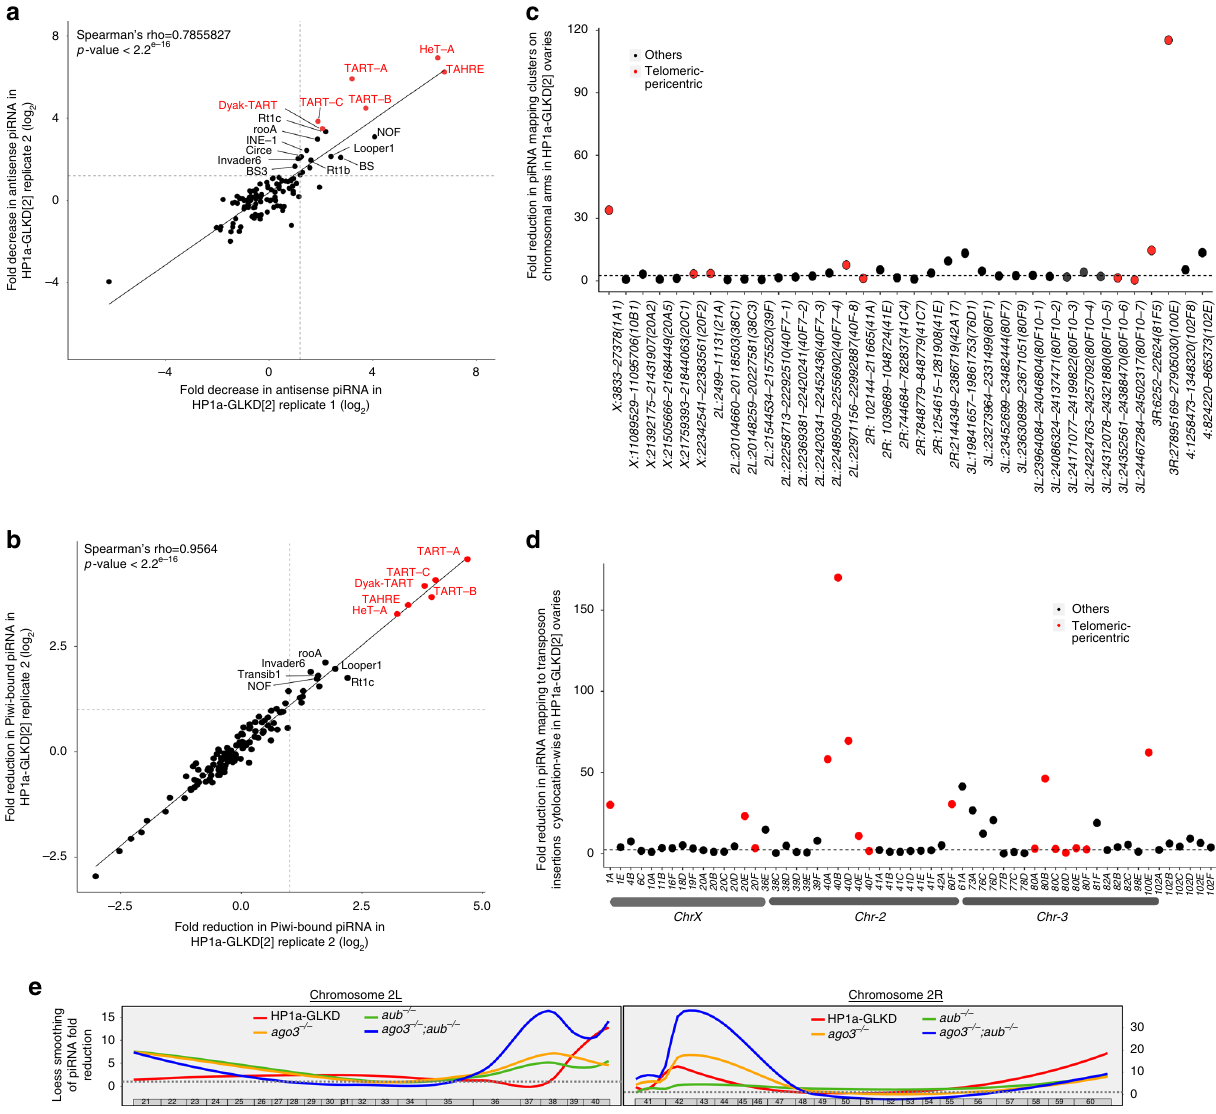
Fig. 2 Loss of HP1a leads to the concomitant selective loss of piRNAs mapping to transposons. a , b Comparison of reduction in canonical transposon mapping piRNAs for a total cellular piRNAs in HP1a-GLKD[2] ovaries and b Piwi-bound piRNAs among two replicates of HP1a-GLKD[2] ovaries in comparison to control. Telomeric transposons, HeT-A , TART , and TAHRE , are labelled in red and correlation in piRNA loss among the replicates was estimated using Spearman ’ s rank correlation test. c Fold reduction in the total cellular piRNAs mapping to clusters on the chromosomal arms. Clusters close to the telomeres and centromeres are represented in red. d Fold reduction in the piRNAs uniquely mapping to transposon insertions, for different cytolocations. The piRNAs uniquely mapping to transposon insertions were consolidated for each cytolocation and the cytolocations having more than 1000 uniquely-mapping piRNAs in control were analysed. e Loess smoothening of the reduction in the 23 – 29-nt reads uniquely mapping to the transposon insertions in chromosome arms 2L and 2R. Fold reductions in those reads in HP1a-GLKD (HP1a-GLKD[2] and HP1a-GLKD[3] average), aub, ago3 , and aub- ago3 ovaries compared with those in their respective controls are